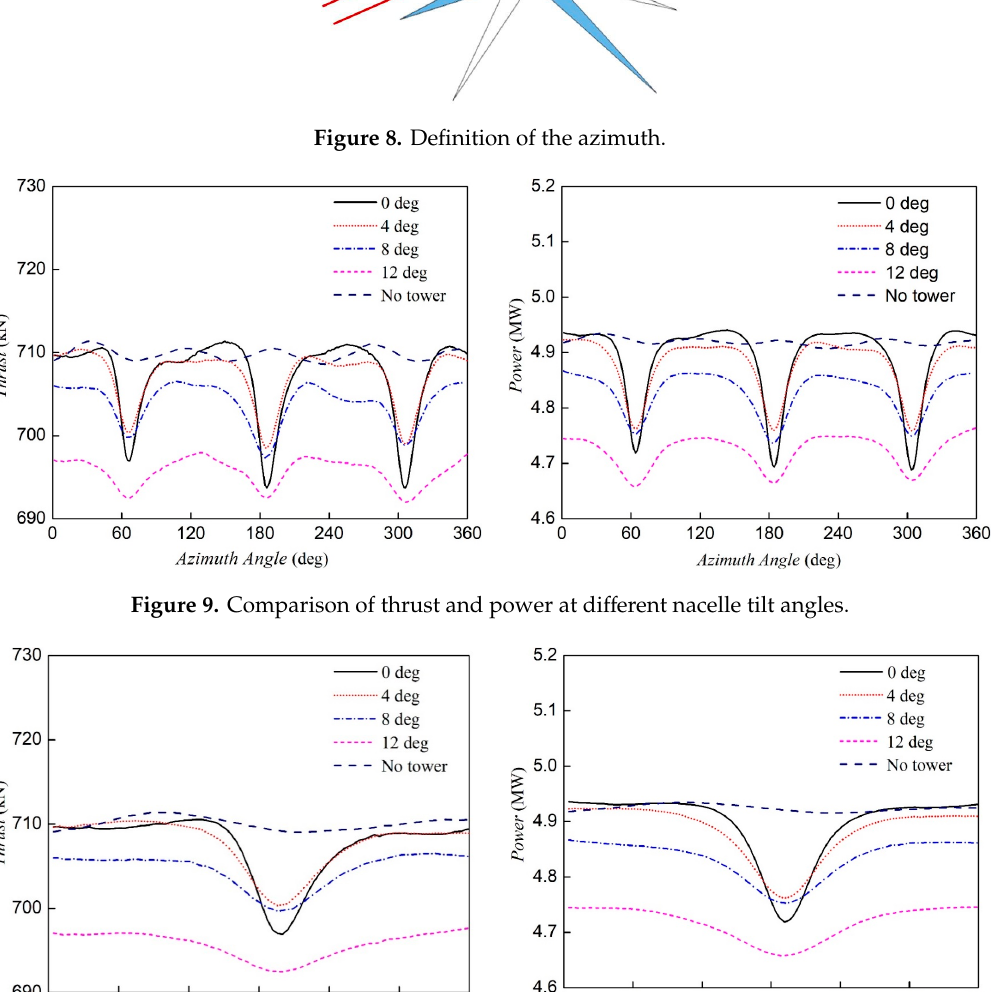
Figure 10. Comparison of thrust and power at different nacelle tilt angles (partial enlargement).